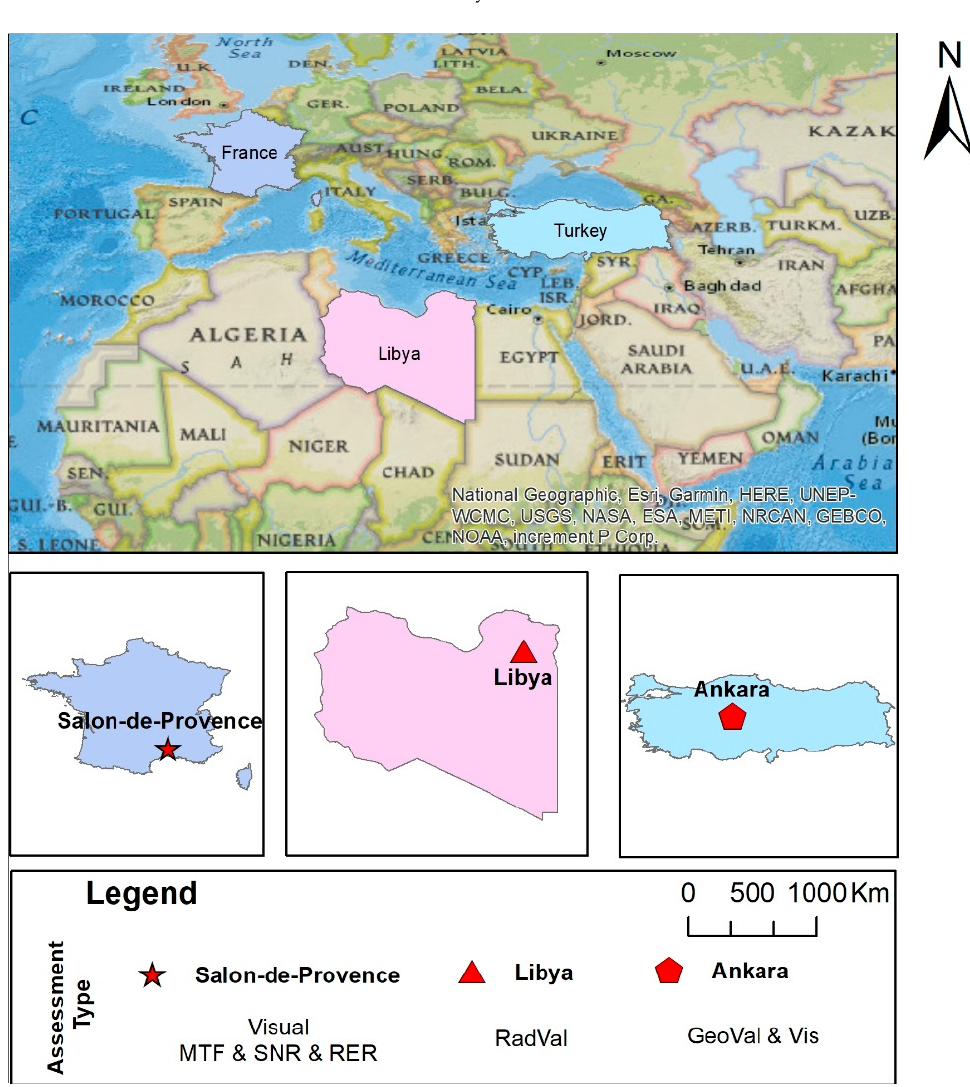
Figure 1. The locations of the EDAP test sites used in this study. Table 2. The main features of the SkySat data used in the study.